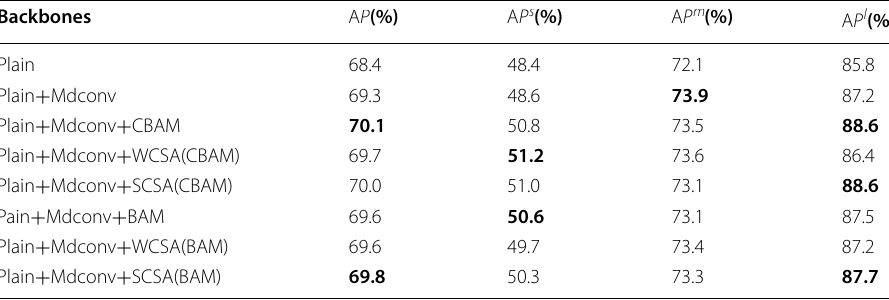
Table 3 Comparisons of average precision (AP) on ResNet-50 and Faster R-CNN with FPN Backbones